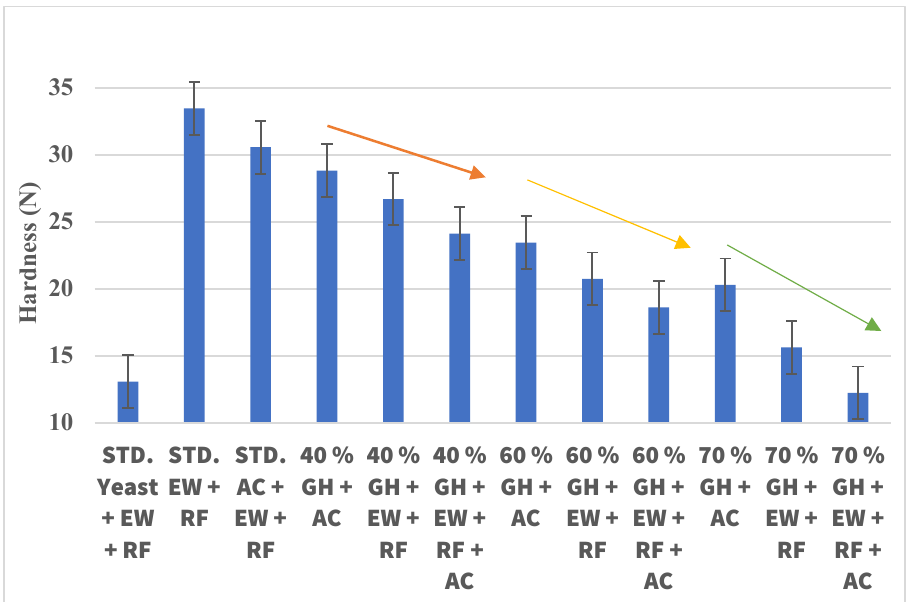
Figure 5. The hardness of the bread made with GH and different gelling agents. The value of hardness decreased when gelling agents were added to the bread.